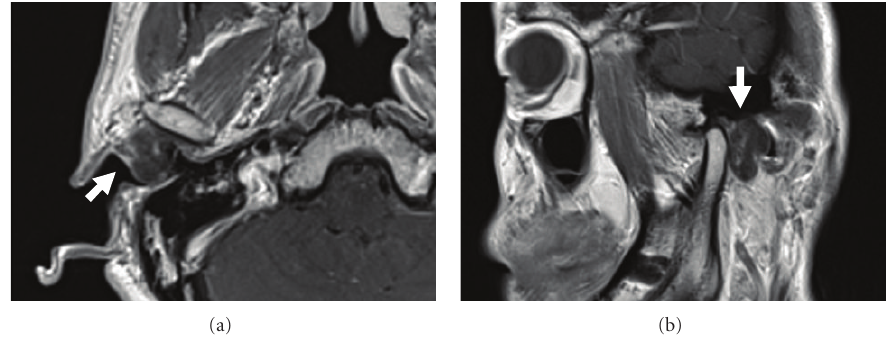
Figure 1: T1 gadolinium-enhanced axial (a) and sagittal (b) magnetic resonance images show a solid tumor (arrow) proximate to the capsule of the right temporomandibular joint in the right preauricular region.